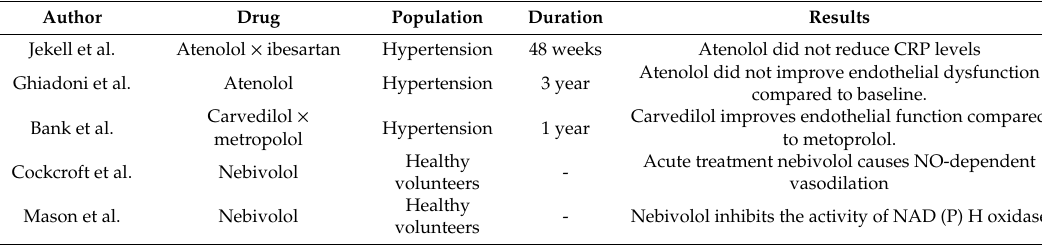
Table 3. Studies showing the e ff ect of beta-blocker treatment on serum C-reactive protein levels and endothelial